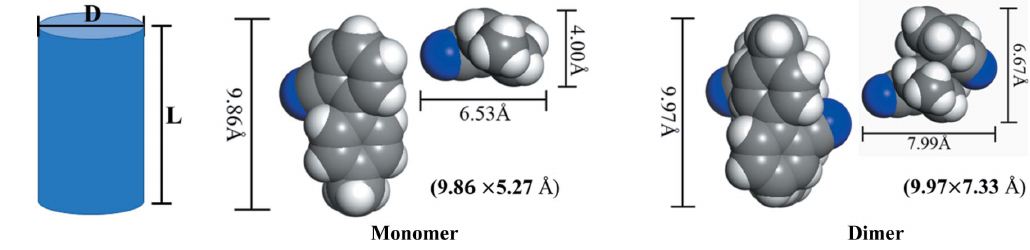
Figure 6 Theoretical dimensions of the monomer and dimer of OTBN. Data in parentheses are the theoretical values fitted to the cylindrical